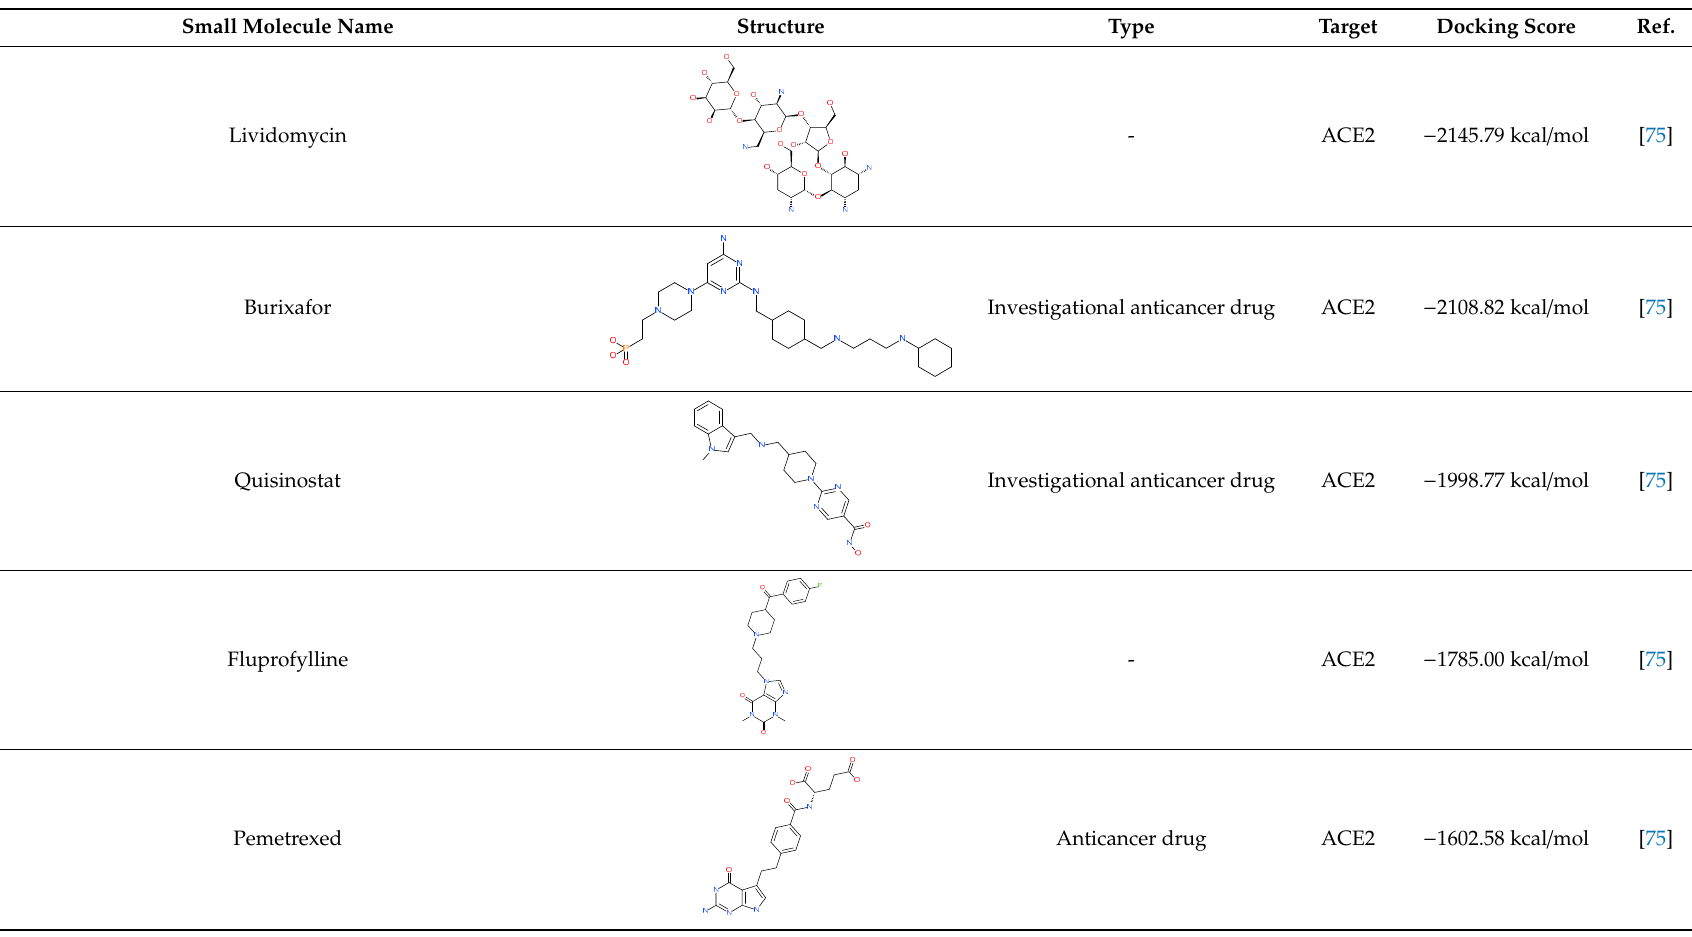
Table 5. Small molecules identified through computational approaches for targeting host ACE2.